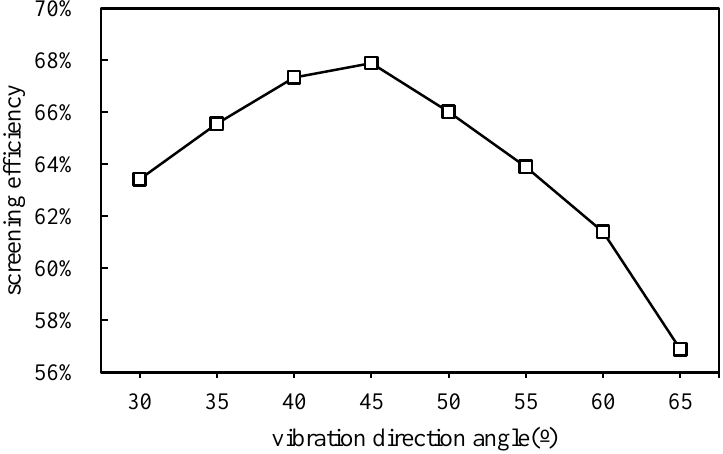
Figure9. Screeningefficienciesofacantileveredvibratingsieve(CVS)fordifferentvibrationdirectionangle. Figure 9. Screening efficiencies of a cantilevered vibrating sieve (CVS) for different vibration direction angle.